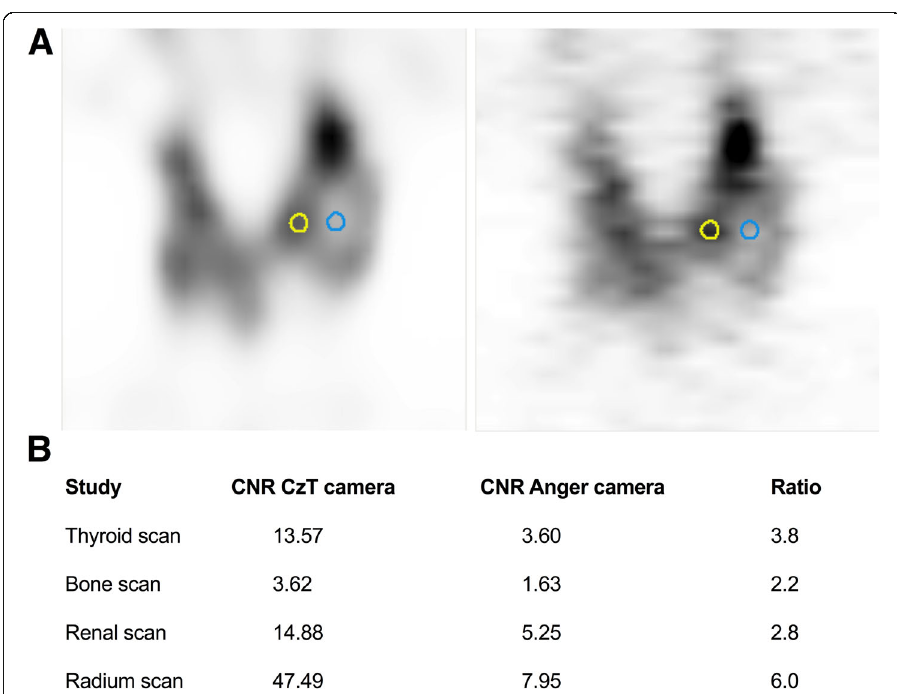
Fig. 5 Example of a manually drawn VOIs for the thyroid study ( a ): spherical VOIs of 5 mm of diameter were drawn on lesion corresponding to a cold nodule (blue) and normal tissue (yellow) VOIs were drawn on CzT camera images (left) and copied to Anger camera images (right). The resulting CNRs were computed for each clinical case and both cameras ( b